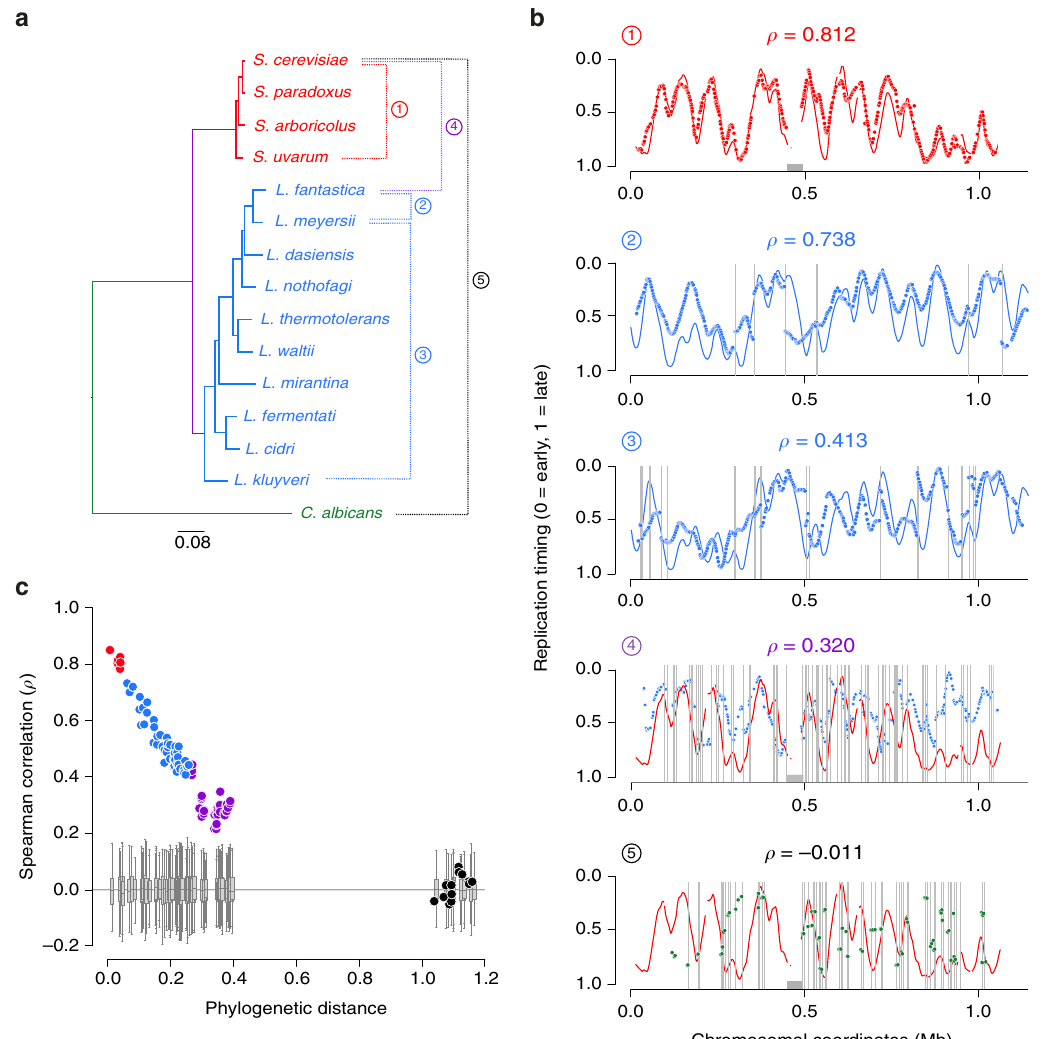
Fig. 1 Evolution of replication timing pro fi les in yeast. a Phylogeny of 15 yeast species inferred from a maximum likelihood analysis of a concatenated alignment of 510 protein families. The circled numbers to the right of the tree relate to the pairwise species comparisons presented in b . b Synteny-based projections of replication timing pro fi les between pairs of species. We projected the replication timing of one species onto the chromosomal coordinates of a second species, using synteny conservation between the two genomes. The color coding is identical to a . The rho value above each pro fi le indicates the genome-wide Spearman ’ s rank correlation coef fi cient between the replication timing programs of the two compared species. Vertical gray bars indicate the position of synteny breakpoints between genomes. Comparisons 1, 4, and 5 represent the projections of S . uvarum , L . fantastica, and C . albicans timing data, respectively, onto the replication pro fi le of S . cerevisiae chromosome XII. The gray rectangle symbolizes the rDNA locus in this chromosome. The comparisons 2 and 3 represent the projections of L . fantastica and L . kluyveri timing data, respectively, onto the replication pro fi le of L . meyersii chromosome 0D. c Correlation between replication pro fi le conservation and phylogenetic distance. Spearman coef fi cients on the y -axis correspond to the synteny-based projections of genome replication timing pro fi les between pairs of species as illustrated in b . Red, blue, purple, and black dot series correspond to intra- Saccharomyces , intra- Lachancea , Saccharomyces vs Lachancea and C . albicans vs all other species comparisons, respectively. The gray boxplots show the Spearman correlation values of a null model where, for each pairwise comparison, we applied a random offset to the coordinates of the syntenic genes in one of the two compared genomes. Whiskers are de fi ned by selecting the values within the range of the 75th and 25th percentile plus or minus 1.5 x (75th percentile – 25th percentile) respectively, and at the maximum distance from the median. The offset was re-de fi ned 100 times in both directions and correlations were calculated for each combination of one offset pro fi le from one genome and one original pro fi le from the other